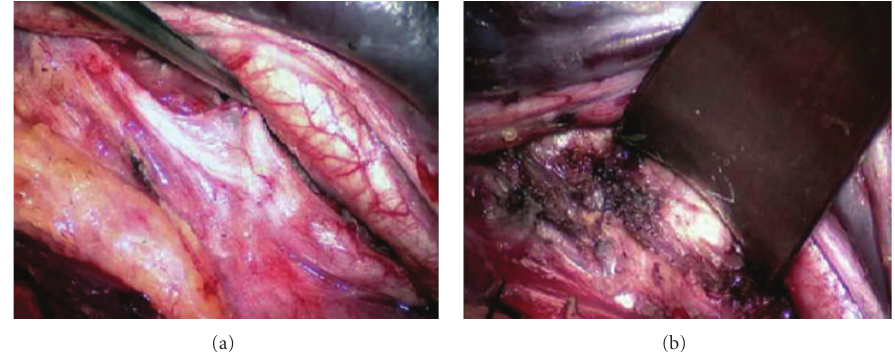
Figure 2: (a, b) Opening the field between the internal jugular vein and the sternocleidomastoid muscle with the fat sheath in the depth.